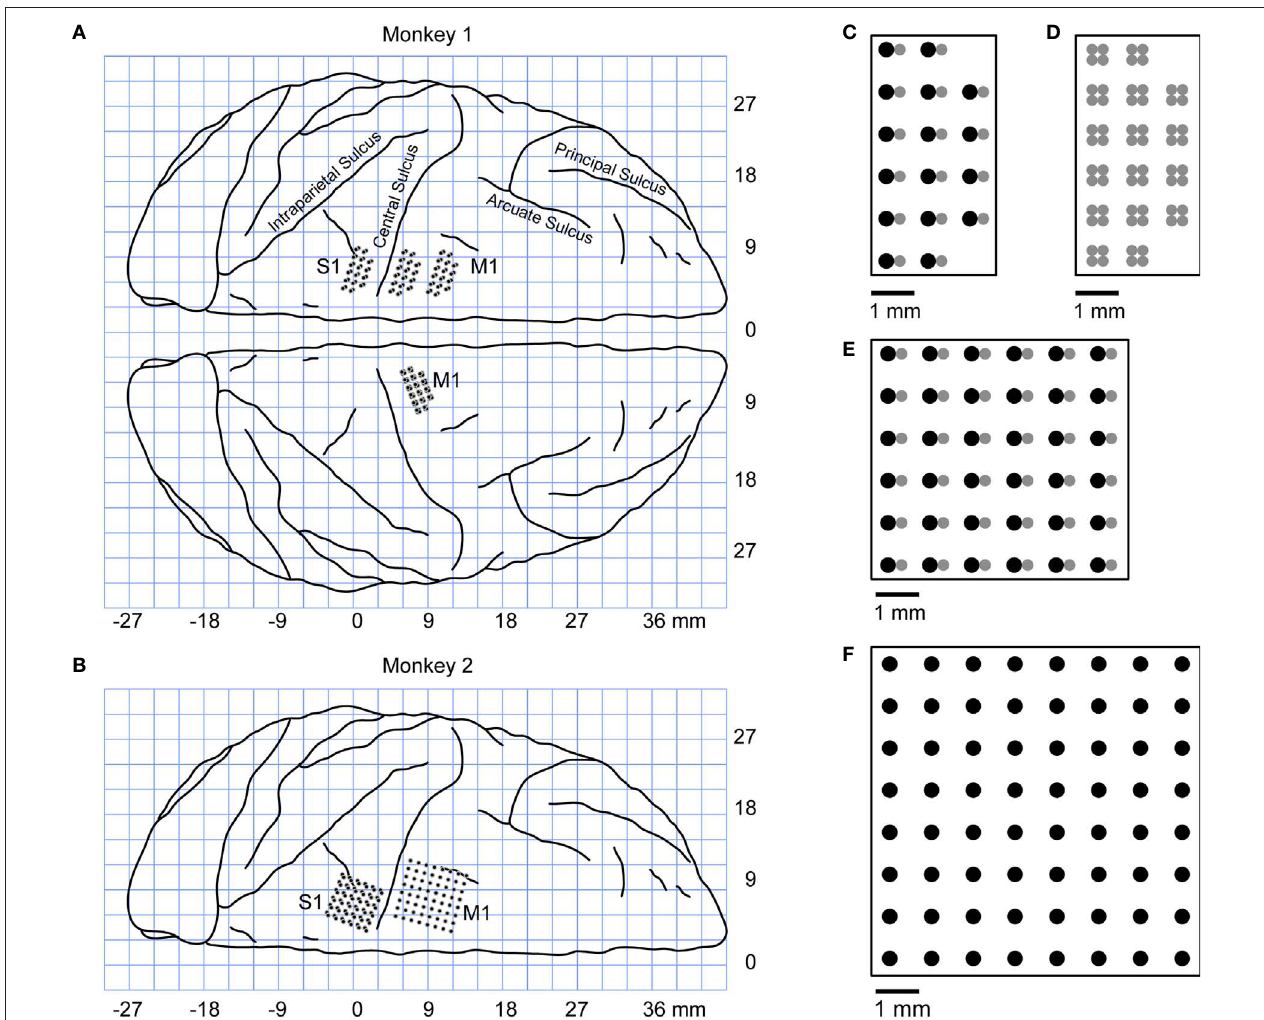
M1. (B) Implanted locations in Monkey 2. The left hemisphere was implanted with two 64-electrode arrays, one placed in M1 and one in S1. (C–F) Confi guration of the microelectrode arrays. The electrode shafts were arranged into 1-mm spaced grids. In multi-layered confi gurations, each shaft consisted of two (C,E) or four (D) microwires of different length. The difference in depth between the electrode layers was 0.3